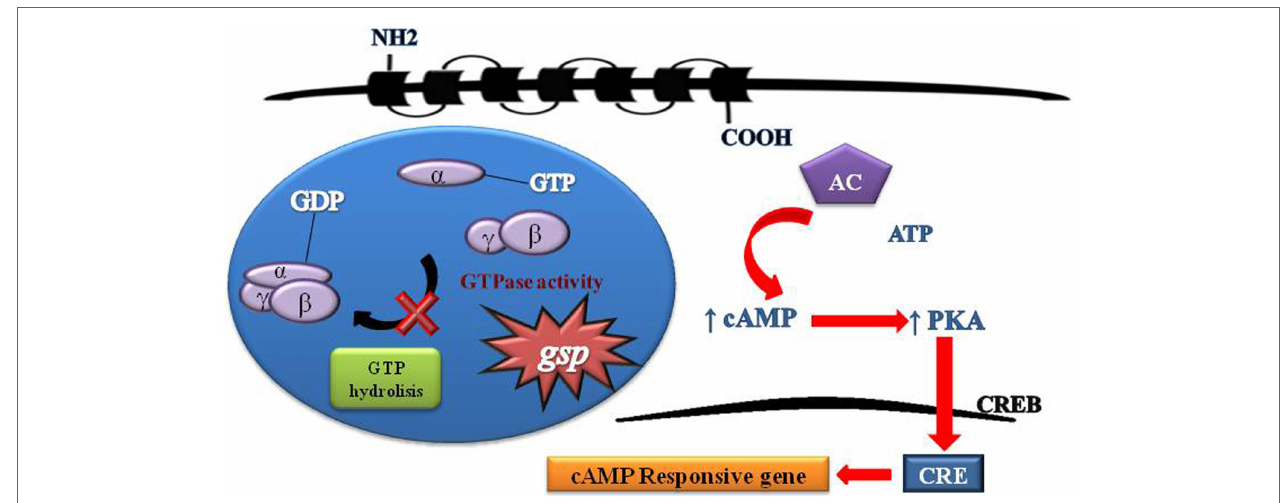
FiGURe 2 | Schematic representation of G protein activation and signaling . Heterotrimeric G proteins are composed of three distinct subunits alpha, beta, and gamma. Activity G protein depends on the alpha subunit. The alpha subunit contains high-affinity binding sites for guanine nucleotides (GDP) and has intrinsic GTPase activity. The GDP-bound form binds tightly to beta and gamma units in its inactive state. The GTP-bound form dissociates from beta and gamma units and serves as a regulator of effectors proteins. The receptor molecules cause the activation of G proteins by facilitating the exchange of GTP for GDP on the alpha subunit. The duration of subunit separation is timed by the rate of alpha subunit-mediated hydrolysis of GTP. The gsp mutations Arg201Cys and Gln227Arg at exons 8 and 9, respectively, of GNAS causing a constitutive signal of cAMP